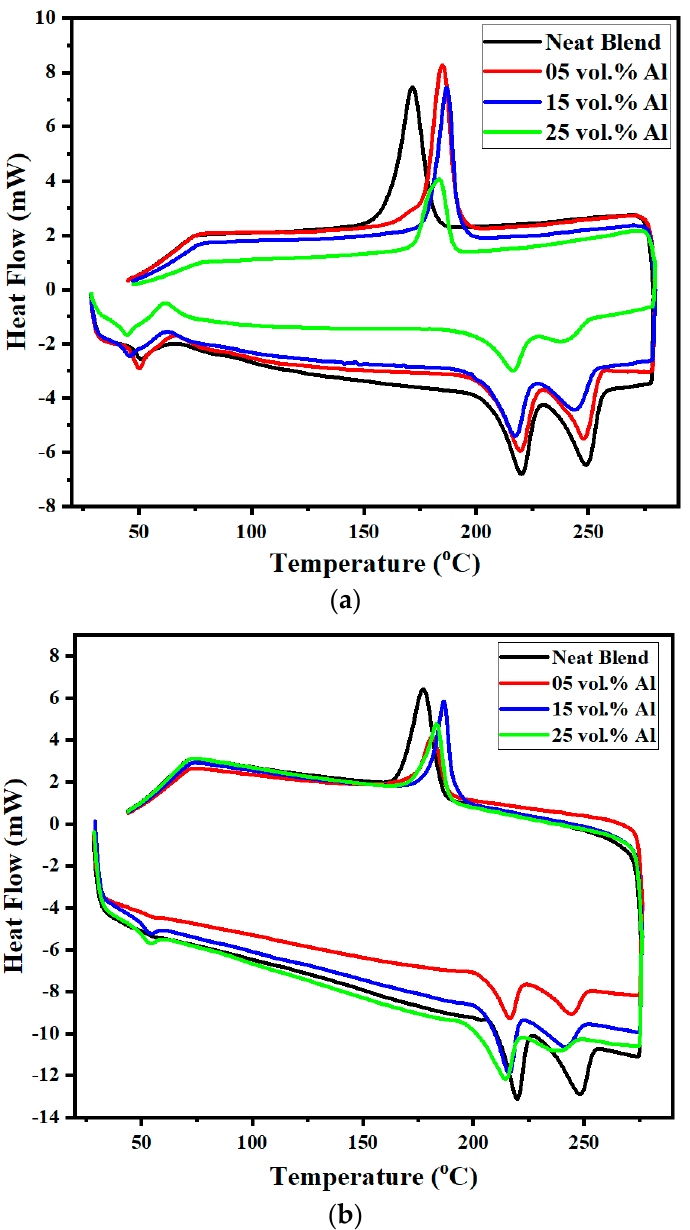
Figure 6 . ( a ) DSC of the shaved skins of 60/40 PBT/PET and Al-60/40 PBT/PET bars shows a cold crystallisation exothermic peak at ~60 °C after the T g , at ~50 °C, during heating. It indicates there is an amorphous skin in all of them; the arrow indicates the exothermic cold crystallisation during the scan. ( b ) DSC of 60/40 PBT/PET and Al-60/40 PBT/PET (core of moulded bars after shaving off the skin) shows no cold crystallization after the T g . This indicates the polymers in the core of the bars had crystallized during moulding.